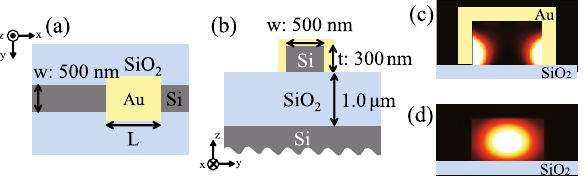
Figure 1. Schematics of the hybrid plasmonic waveguide structure: ( a ) the x-y plane view and ( b ) the y-z plane view. Electric field intensity distributions in the y-z plane at wavelength of 1300 nm: ( c ) SPPs in the hybrid plasmonic waveguide and ( d ) guided light in the optical waveguide.